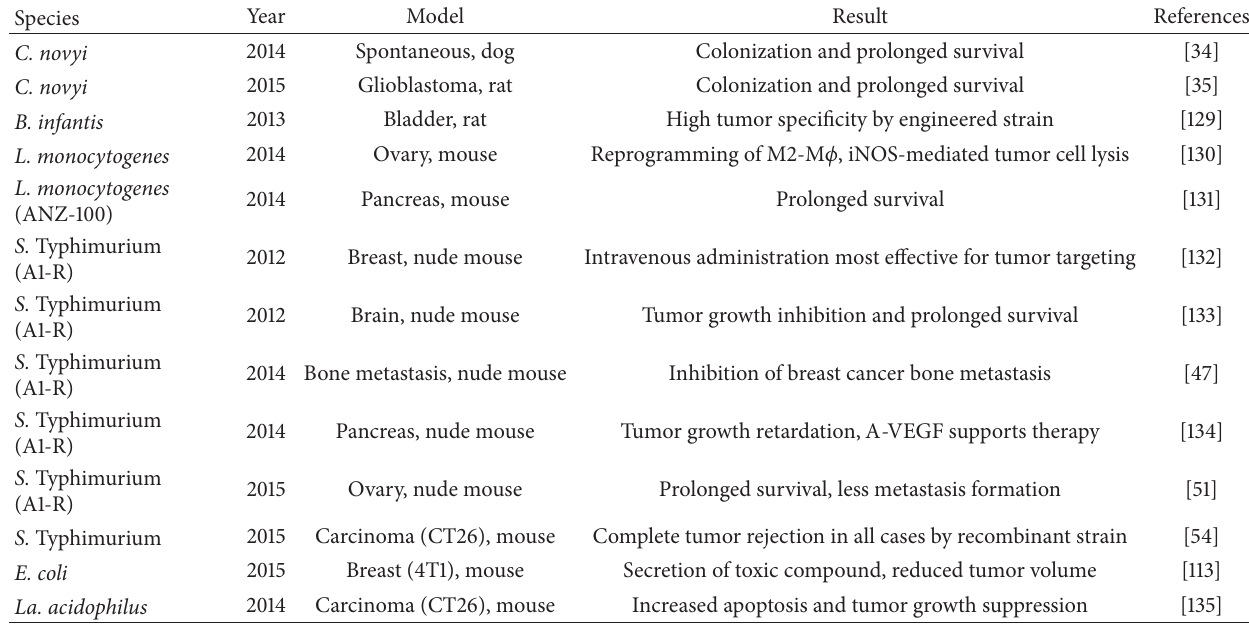
Table 1: Recent representative preclinical examples of bacteria mediated tumor therapy (BMTT) in vivo from 2012 onwards. Species